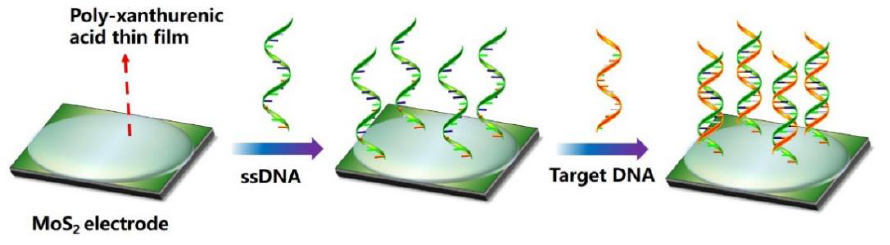
Figure 3. Schematic display of high-performance polymer biosensor based on poly-xanthurenic-acid-functionalized MoS 2 nanosheets.